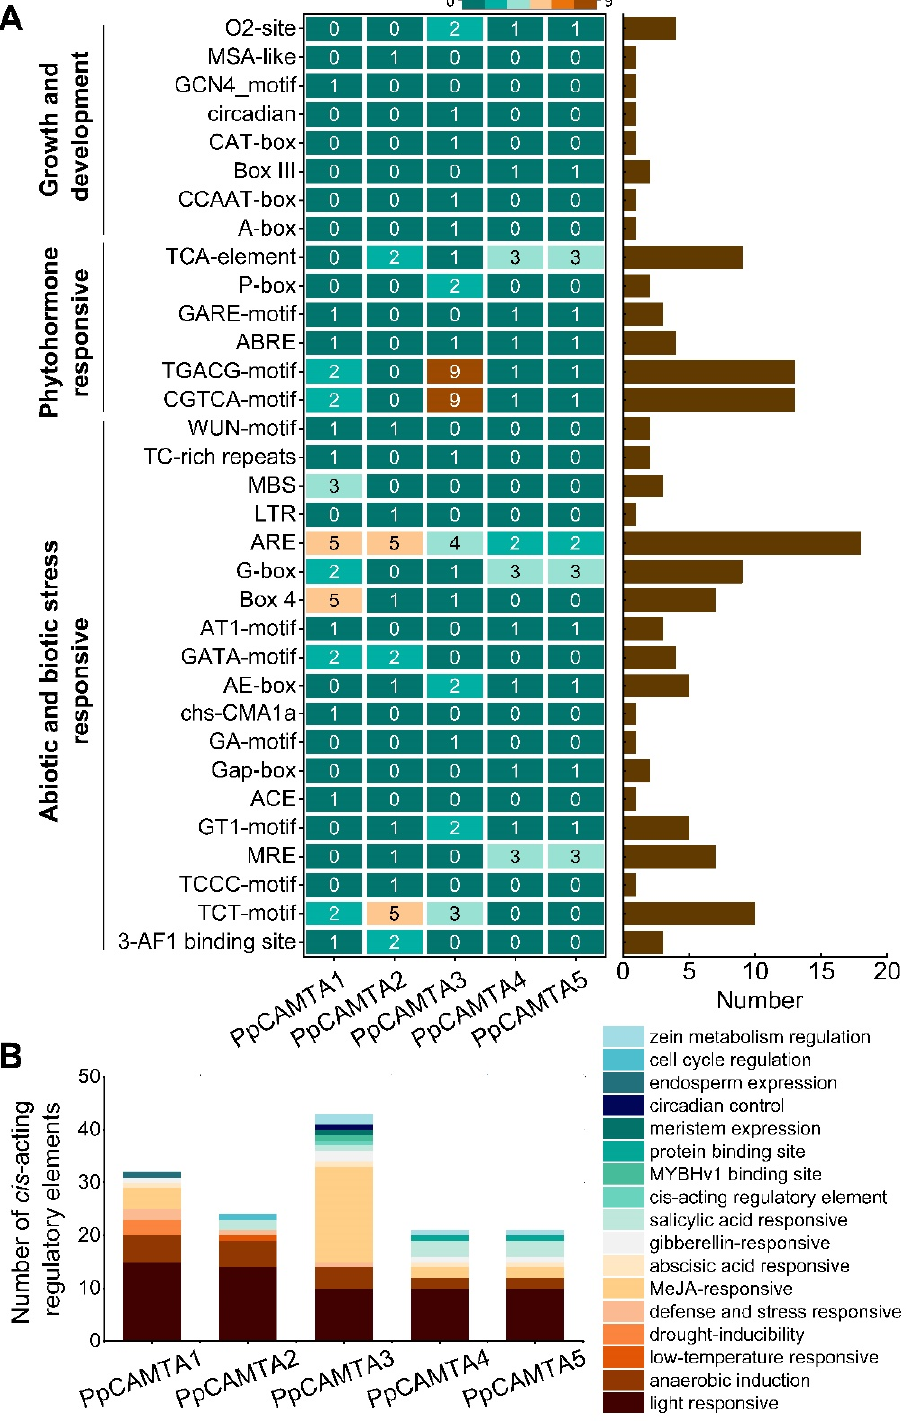
Figure 3. Analysis of cis -acting regulatory elements of peach CAMTA s. ( A ) Distribution of different cis -acting motifs for peach CAMTAs promoter region. Counts of each cis -acting motif were shown in the column diagram on the right. The cis -acting motifs were classified into three major groups depending on their functional annotation. ( B ) The number of predicted cis -acting elements in promoter region of peach CAMTA